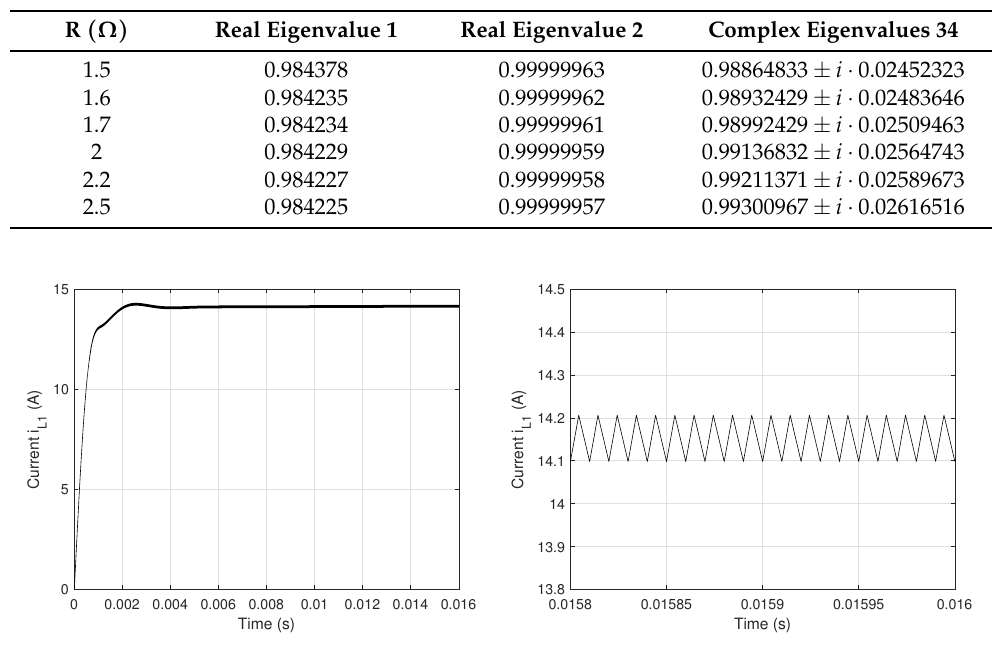
Figure 13. Locus of the eigenvalues of the monodromy matrix varying R in faulty switching condition h 1 = h 2 = 1, h 3 = 0, and with a slope compensation. Table 3. Eigenvalues of the monodromy matrix in faulty switching case h 1 = h 2 = 1, h 3 = 0 and with a slope compensation.